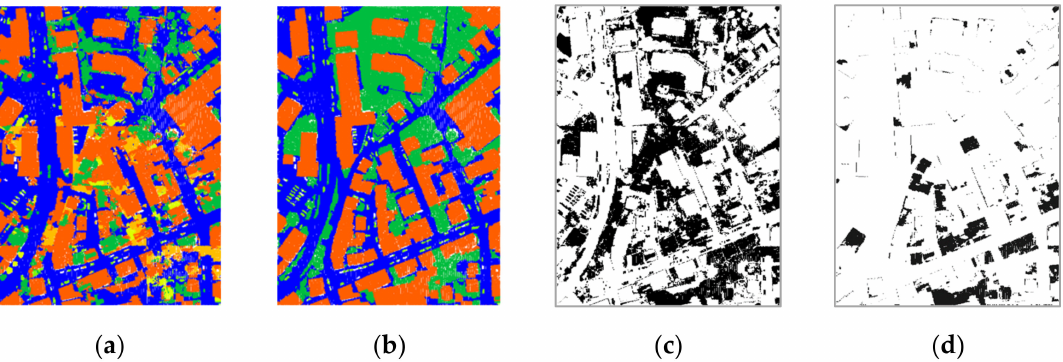
Figure 22. Results of semantic segmentation of new data 1 for Case 1: ( a ) prediction; ( b ) ground truth (i.e., label data); ( c ) difference between prediction and ground truth for all classes; ( d ) difference between prediction and ground truth for building class only.